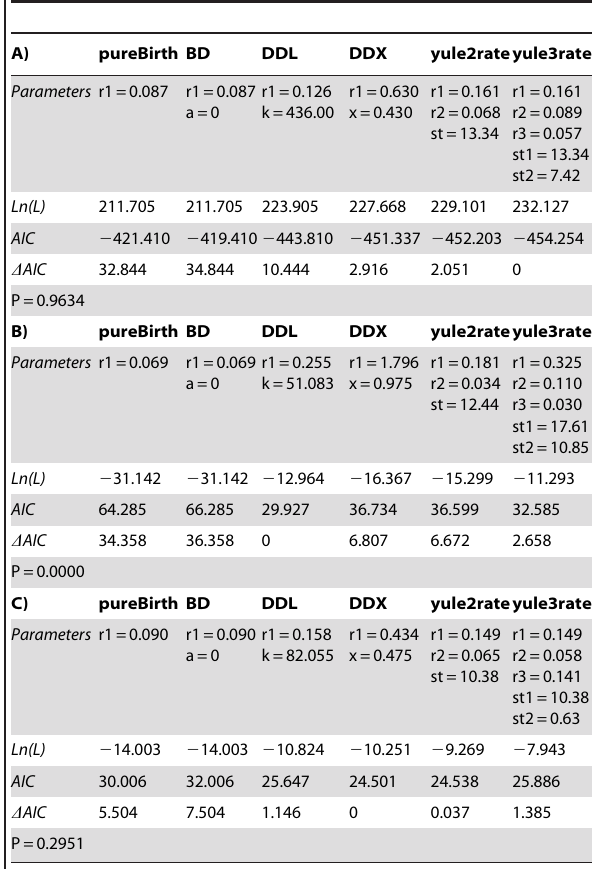
Table 4. Results of fitting diversification models to the Drosophila subgenus (A), the tripunctata and closely related species groups (B), and the repleta and closely related species groups